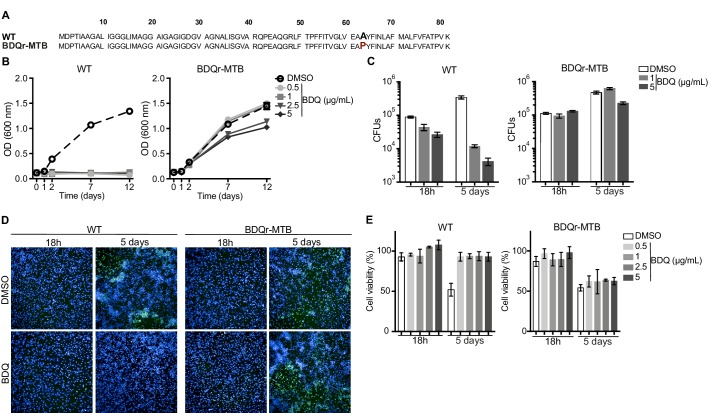
Generation of BDQ resistant MTB strain (BDQr-MTB) and evaluation of its virulence.(A) Amino acid sequence alignment of the ATP synthase c-subunit gene in wild-type (WT) and BDQ-resistant H37Rv strain. The mutation was indicated in red, at position 63. (B) Optical density (OD) measurements of bacterial growth of WT and BDQr-MTB. Bacteria were cultured in 7H9 medium supplemented with 10% OADC enrichment with/without BDQ. (C) Intracellular growth of wild-type (WT) and BDQ-resistant H37Rv strain. Macrophages were infected with the two strains and incubated with BDQ. After 18 hr and 5 days, the cells were lysed and the number of bacterial colonies was counted. (D) Macrophages were infected with WT and BDQr-MTB expressing the GFP protein and treated with BDQ. After 18 hr and 5 days post-infection, the cells were analyzed by confocal microscopy. DAPI (blue) was used to visualize nuclei. (E) Determination of the number of DAPI-positive cells, relative to uninfected macrophages. One representative experiment (of three) is shown. Results are means ± SD. **p<0.01, unpaired two tailed Student’s t test.